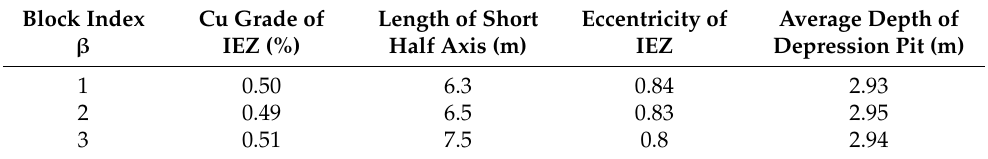
Figure 10. Results of ore draw simulation ( κ = 10%). ( a ) Block index β = 1; ( b ) Block index β = 2; ( c ) Block index β = 3. Table 3. Result of particle flow simulation under different block indexes ( κ = 10%).